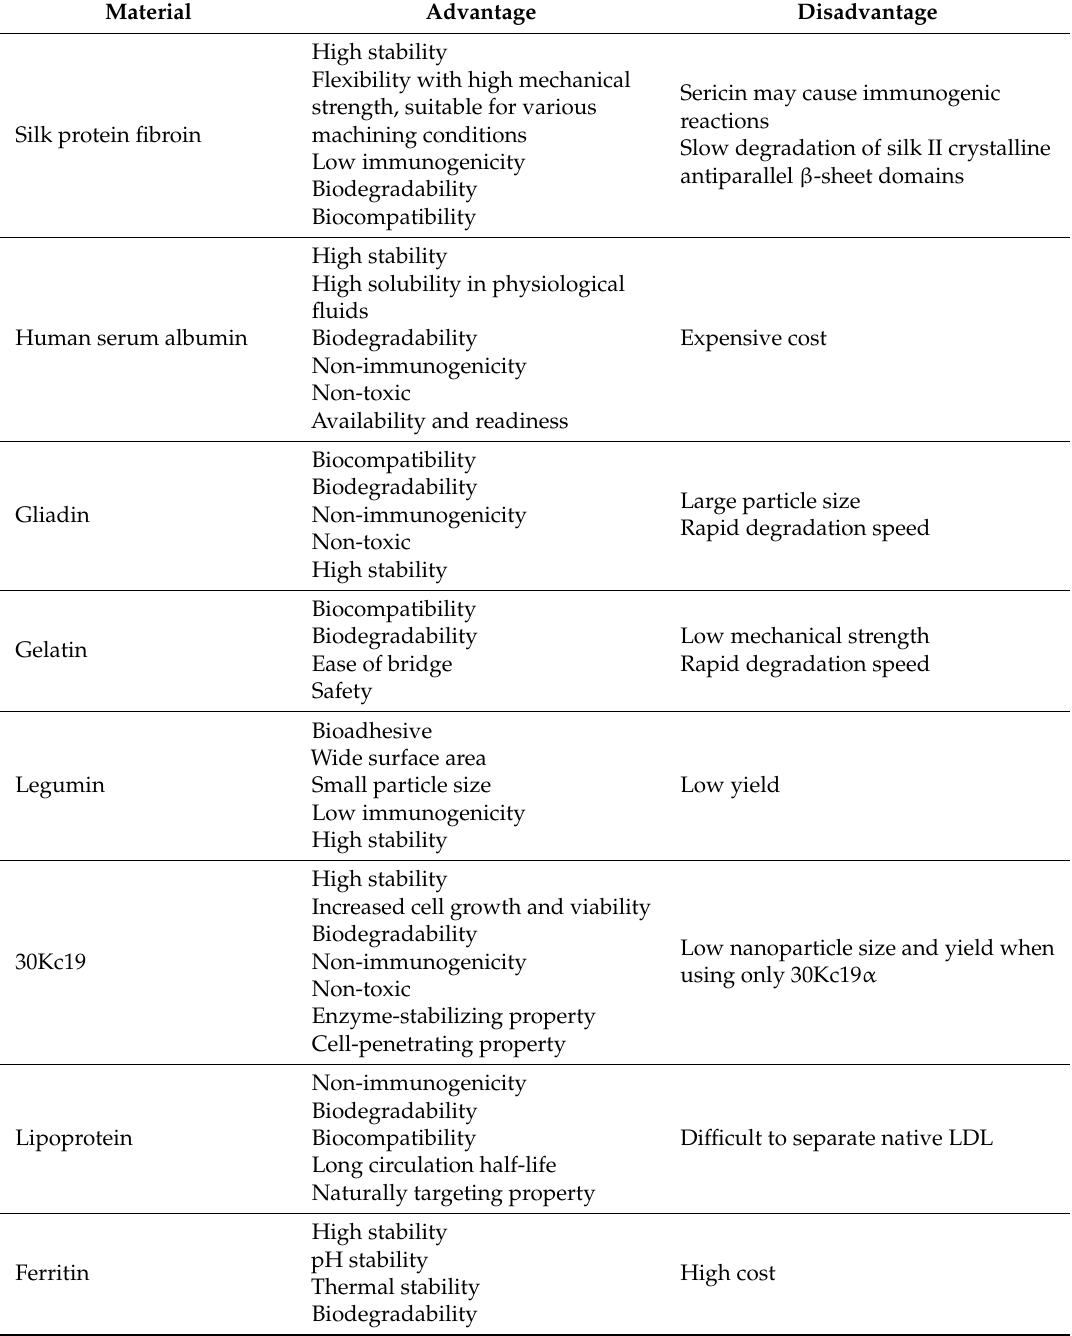
Table 1. Advantages and disadvantages of each protein